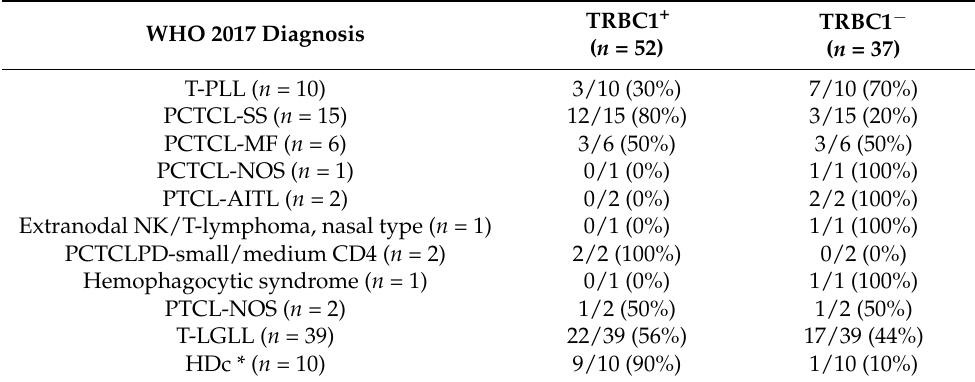
Table 5. TRBC1 expression profile in different WHO diagnostic categories of SmCD3 + T αβ -cell CLPD ( n = 79) plus HDc ( n =